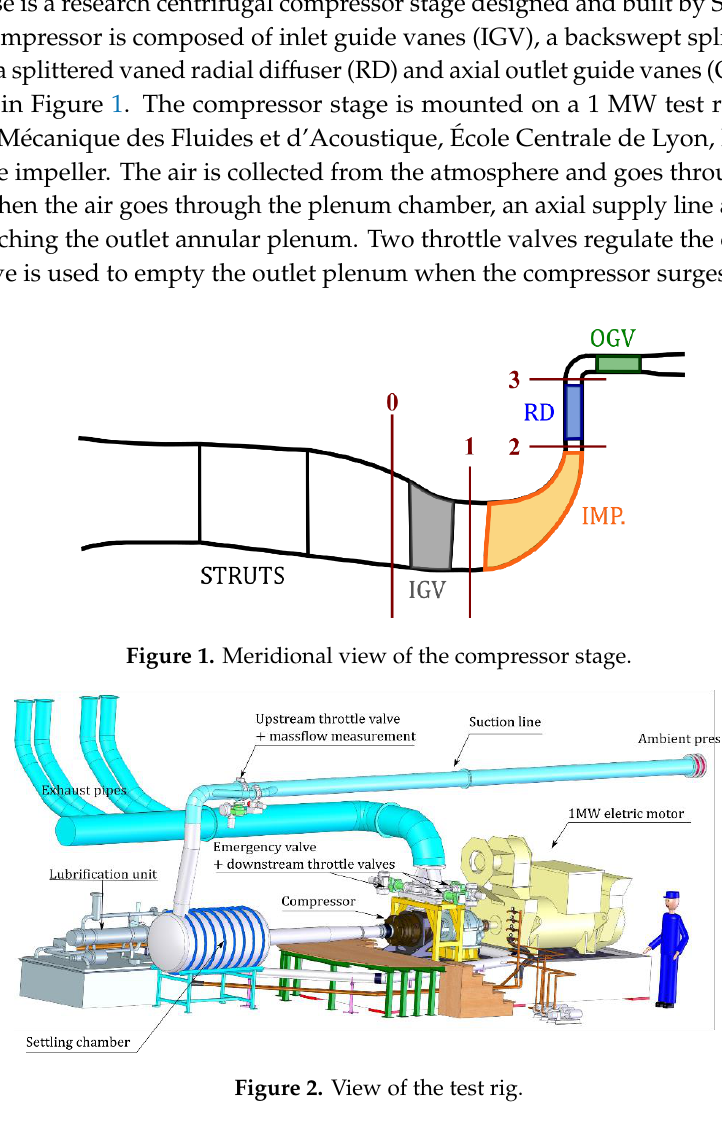
Figure 2. View of the test rig .